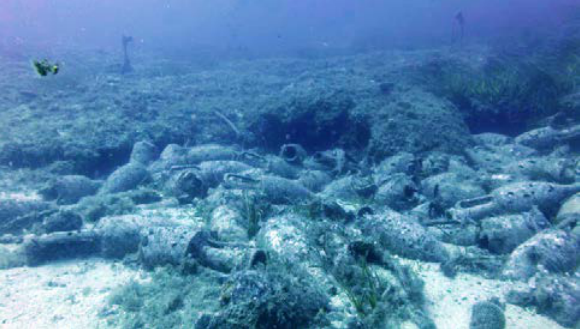
Figure 2. Submerged archaeological remains in the underwater site of Cala Minnola